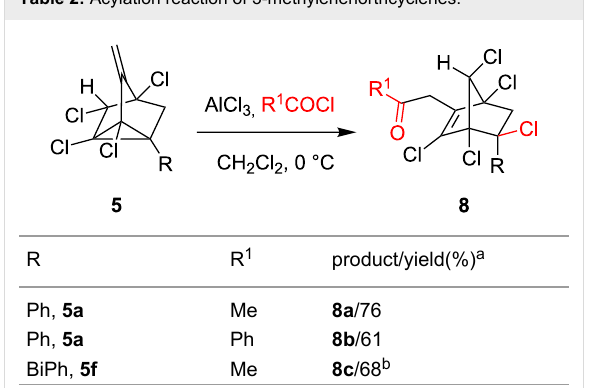
Table 2: Acylation reaction of 3-methylenenortricyclenes.